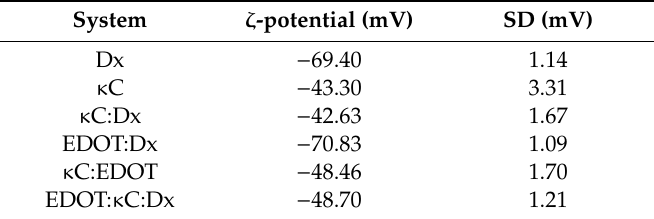
Table 1. ζ -potential values of dispersions used in the fixation of the drug on the electrode.